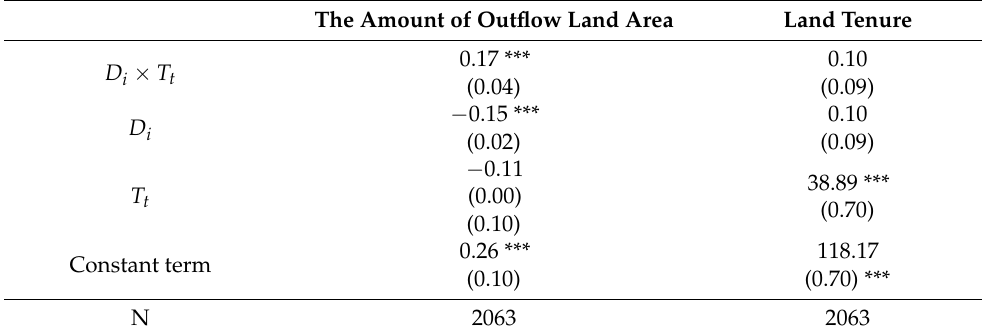
Table A3. Estimation results of the impacts of subsidy reform on the amount of outflow land area and land